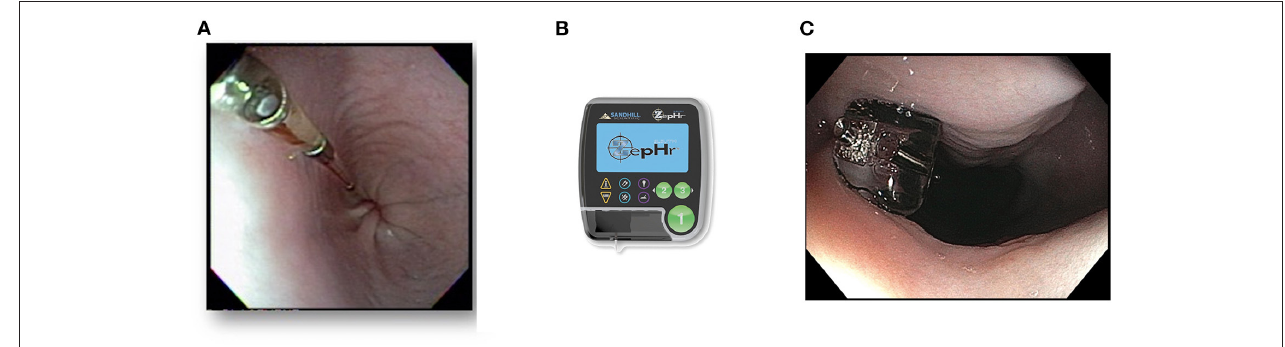
FIGURE 10 | Multichannel intraluminal impedance/pH (MII-pH) catheter and ambulatory pH capsule. (A) Photographed is a 6.4-French (2.13mm) esophageal multi-use impedance/pH probe in the esophagus of a dog patient. (B) The recording device (ZepHr) that the impedance/pH probe connects to. (C) A wireless